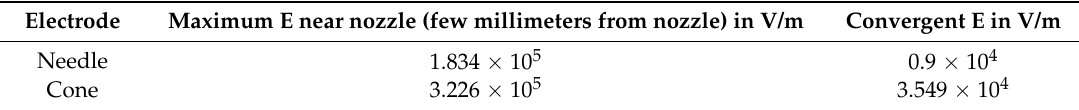
Table 2. Comparison of the values of E between cone electrode and the typical electrospinning setup. Electrode